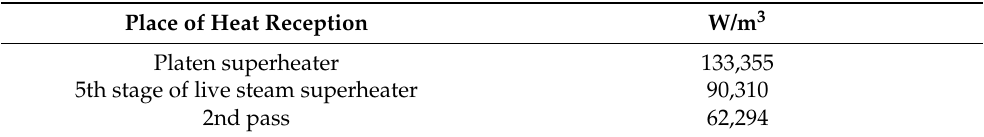
Table 5. Amounts of heat flux